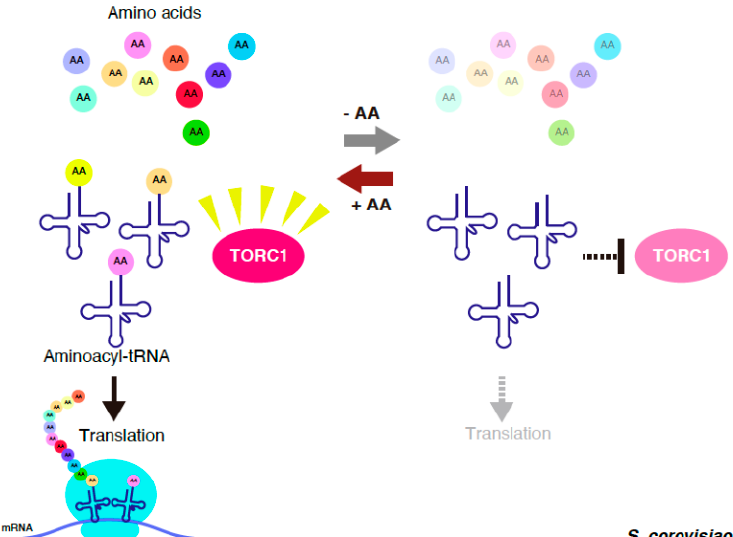
Figure 1. Transfer RNA (tRNA)-mediated target of rapamycin complex 1 (TORC1) regulation in Saccharomyces cerevisiae . Under amino acid-rich conditions, tRNAs are charged with cognate amino acids, and the resultant aminoacyl-tRNAs are delivered to the ribosome for translation. Upon amino acid starvation, free uncharged tRNAs increase, and the accumulated free tRNAs inactivate TORC1.